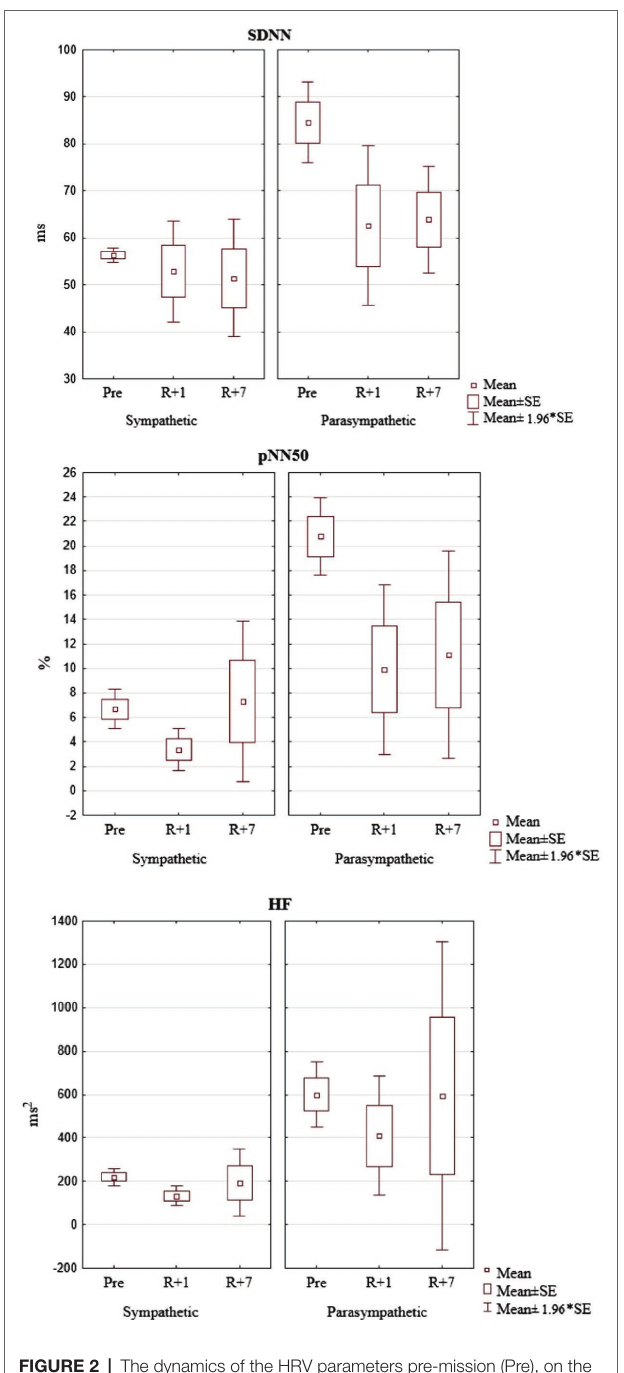
FIGURE 2 | The dynamics of the HRV parameters pre-mission (Pre), on the 1st day (R + 1) and on the 7th day (R + 7) after landing (the cosmonauts are grouped into clusters depending on the time of